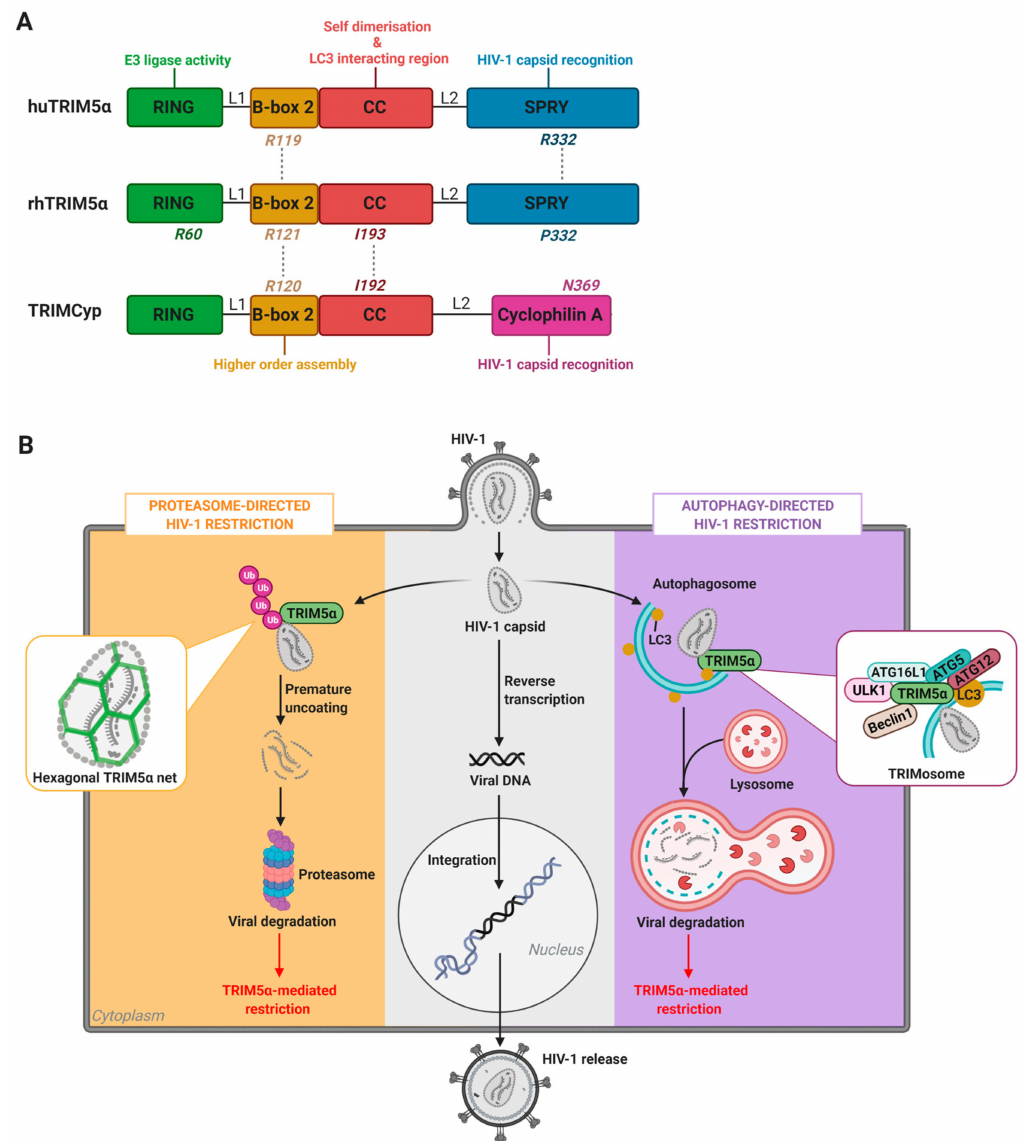
Figure 1. Structure and functions of TRIM5 α . ( A ) Rhesus (rh)TRIM5 α , human (hu)TRIM5 α , and TRIMCyp protein domain organization and associated functions. Key amino acid residues impacting antiviral functions per protein domain are depicted. ( B ) Schematic overview of the main steps of HIV-1 virus replication cycle (center panel, in grey), and the proteasome-directed (left panel, in orange) and autophagy-directed (right panel, in purple) TRIM5 α -mediated mechanisms of HIV-1 restriction. RING: really interesting new gene, CC: coiled-coil, LC3: microtubule-associated protein 1A/1B-light chain 3, ULK1: Unc-51 like autophagy activating kinase 1, ATG: autophagy related, Ub: ubiquitin, L1: linker 1, L2: linker